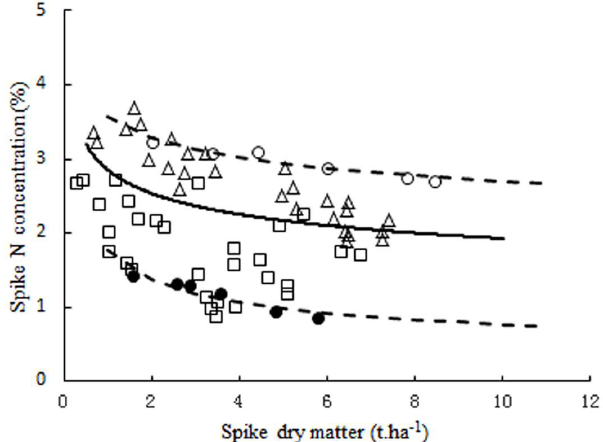
Fig 5. Comprehensive validation of the spike N c curve using the independent data set from the experiment conducted during 2007–2008. Data points ( □ ) and ( 4 ) represent N-limiting and non-N-limiting treatments, respectively. The solid line in the middle represents the critical N curve (N c = 2.85 × SDM -0.17 ) that describesthe relationship between the critical N concentration and spike dry matter of rice. The data points ( ● ) and ( (cid:14) ) that were not used for establishing the parameters of the allometricfunction (2009–2011) were used to develop two limit curves (--------): minimum limit curve (N min = 1.86 × SDM -0.41 ) and maximum limit curve (N max = 3.57 × SDM -0.12